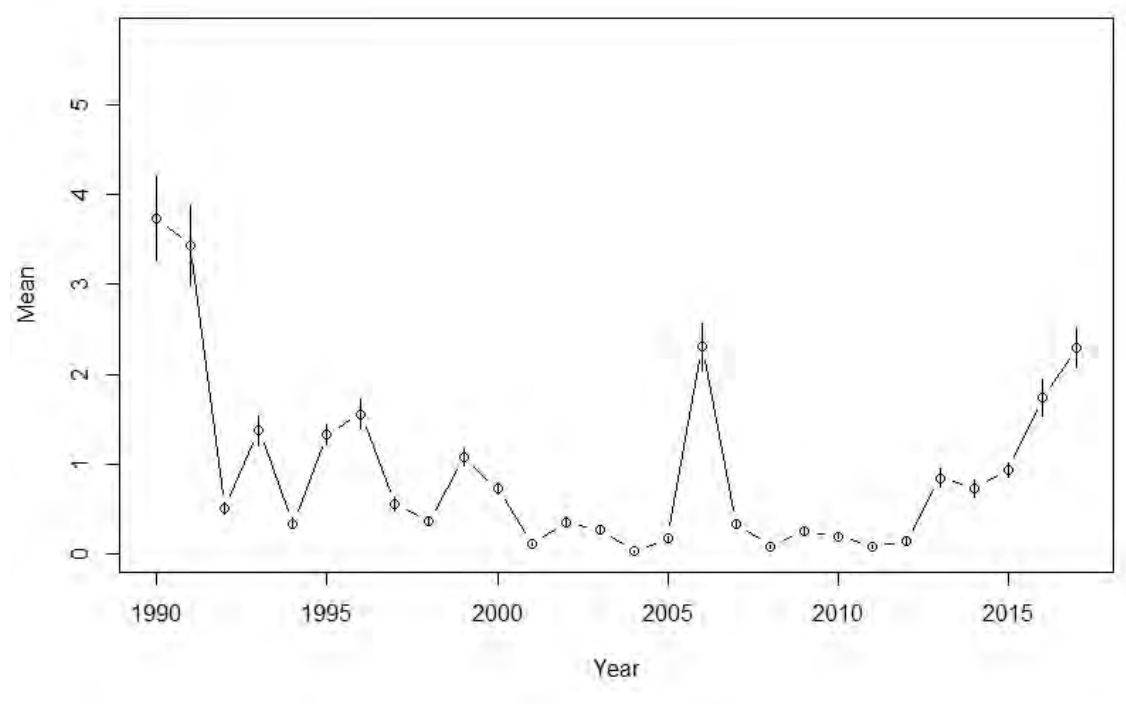
Figure 57. Delaware Fish and Wildlife Adult Trawl Survey abundance index for adult female horseshoe crabs in fall (September through December).